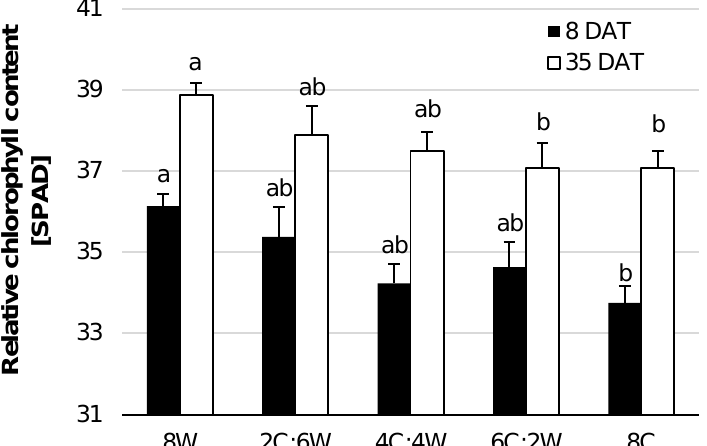
Figure 7. Leaf relative chlorophyll fluorescence (Fv/Fm), 8, 16, 28 and 35 DAT. Vertical bars denote standard errors of means.